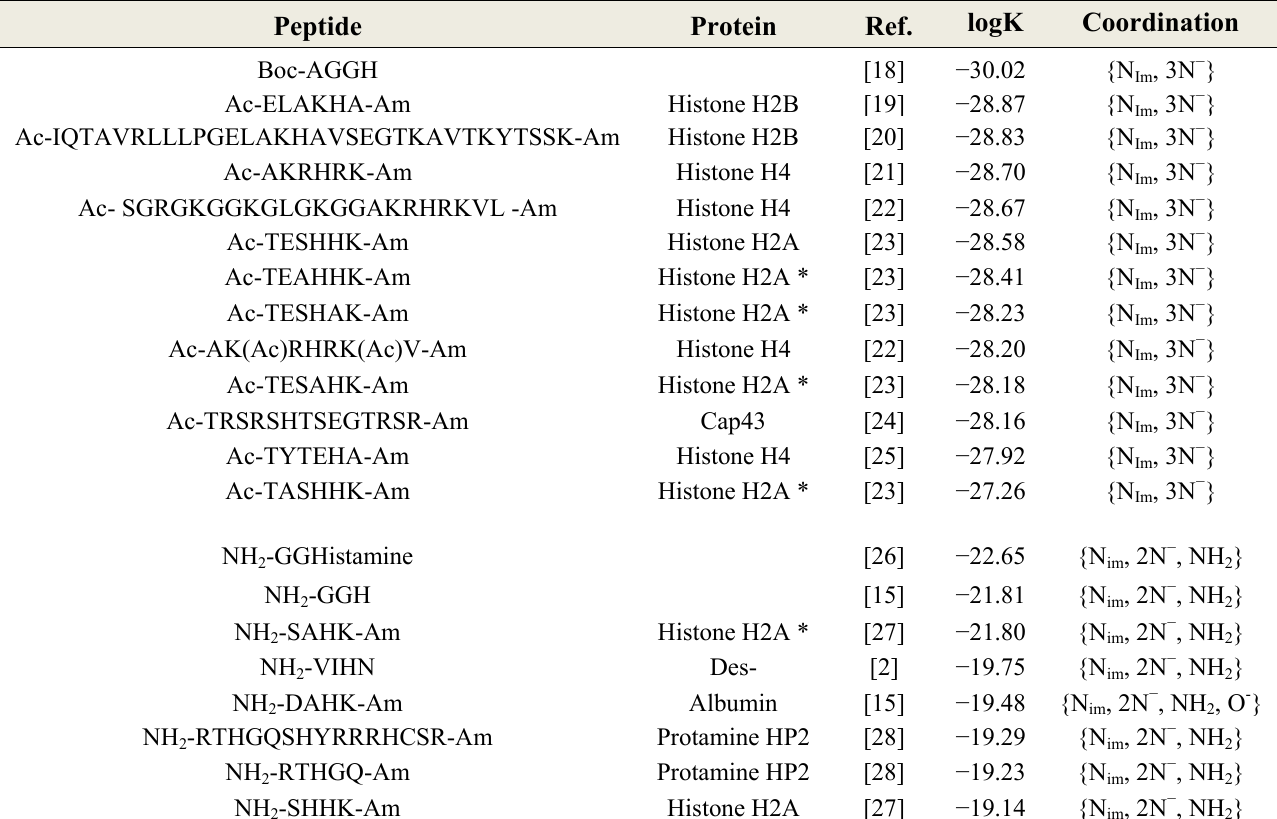
Table 1. log K* (4N) values of Ni(II) complexes of comparable XYH peptides. Peptide Protein Ref. logK Coordination Boc-AGGH [18] Ac-ELAKHA-Am Histone H2B Histone